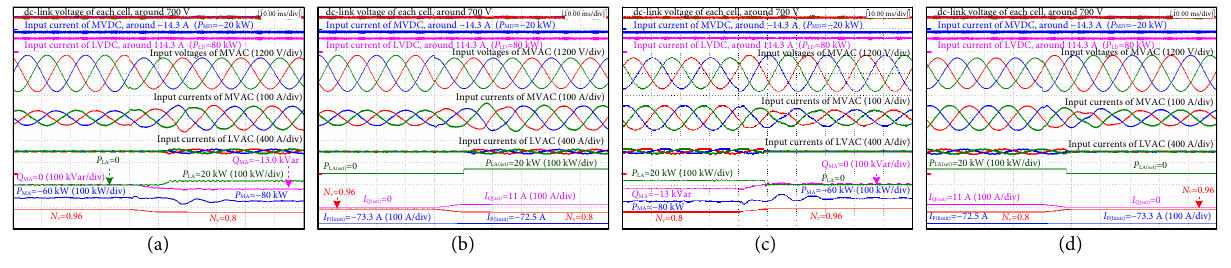
Fig. 17 Experimental results of LVRT Mode-2 in Case-1 of active-power configuration. (a) Real-time power curve in the voltage sag process. (b) Power command curve in the voltage sag process. (c) Real-time power curve in the voltage recovery process. (d) Power command curve in the voltage recovery process. dc-link voltage of each cell, around 700 V Input current of MVDC, around −14.3 A ( P MD ≈−20 kW) Input current of LVDC, around 85.7 A ( P LD ≈60 kW)